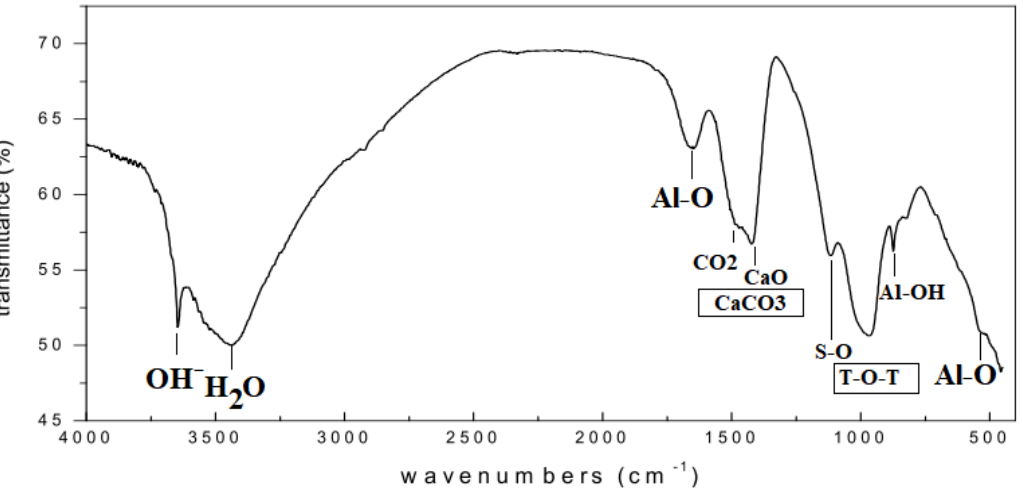
Figure 8. FTIR spectra in ordinary Portlandite cement (From IntechOpen Ref. [58] and used under Creative Commons CC-BY license).